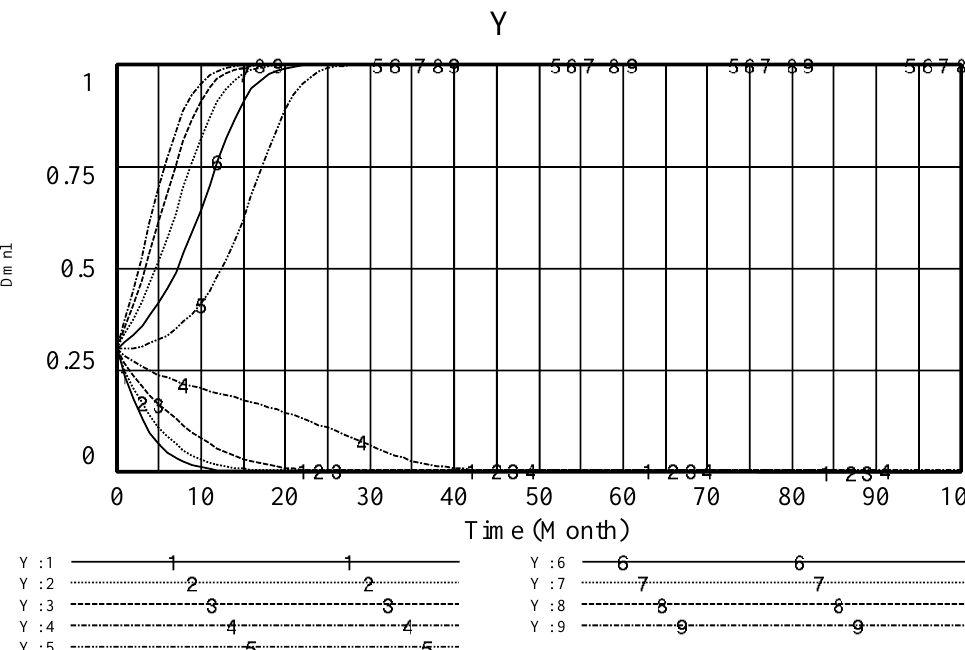
Figure 5. Simulation result of x when initial value of x is 0.6.